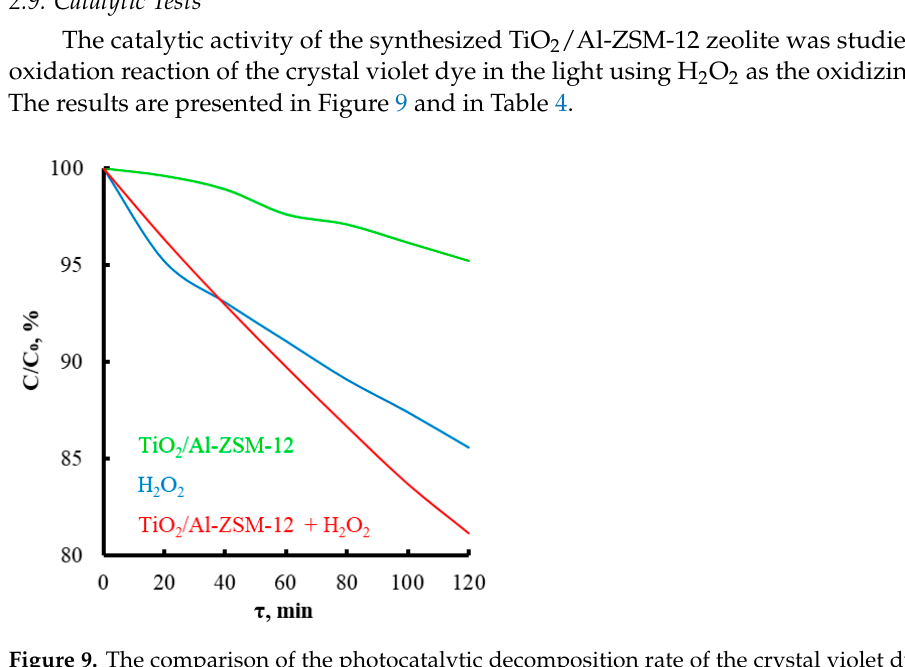
Figure 9. The comparison of the photocatalytic decomposition rate of the crystal violet dye in the presence and absence of hydrogen peroxide. presence and absence of hydrogen peroxide. Table 4. Measured dye concentration in photocatalytic and control Table 4. Measured dye concentration in photocatalytic and control experiments.